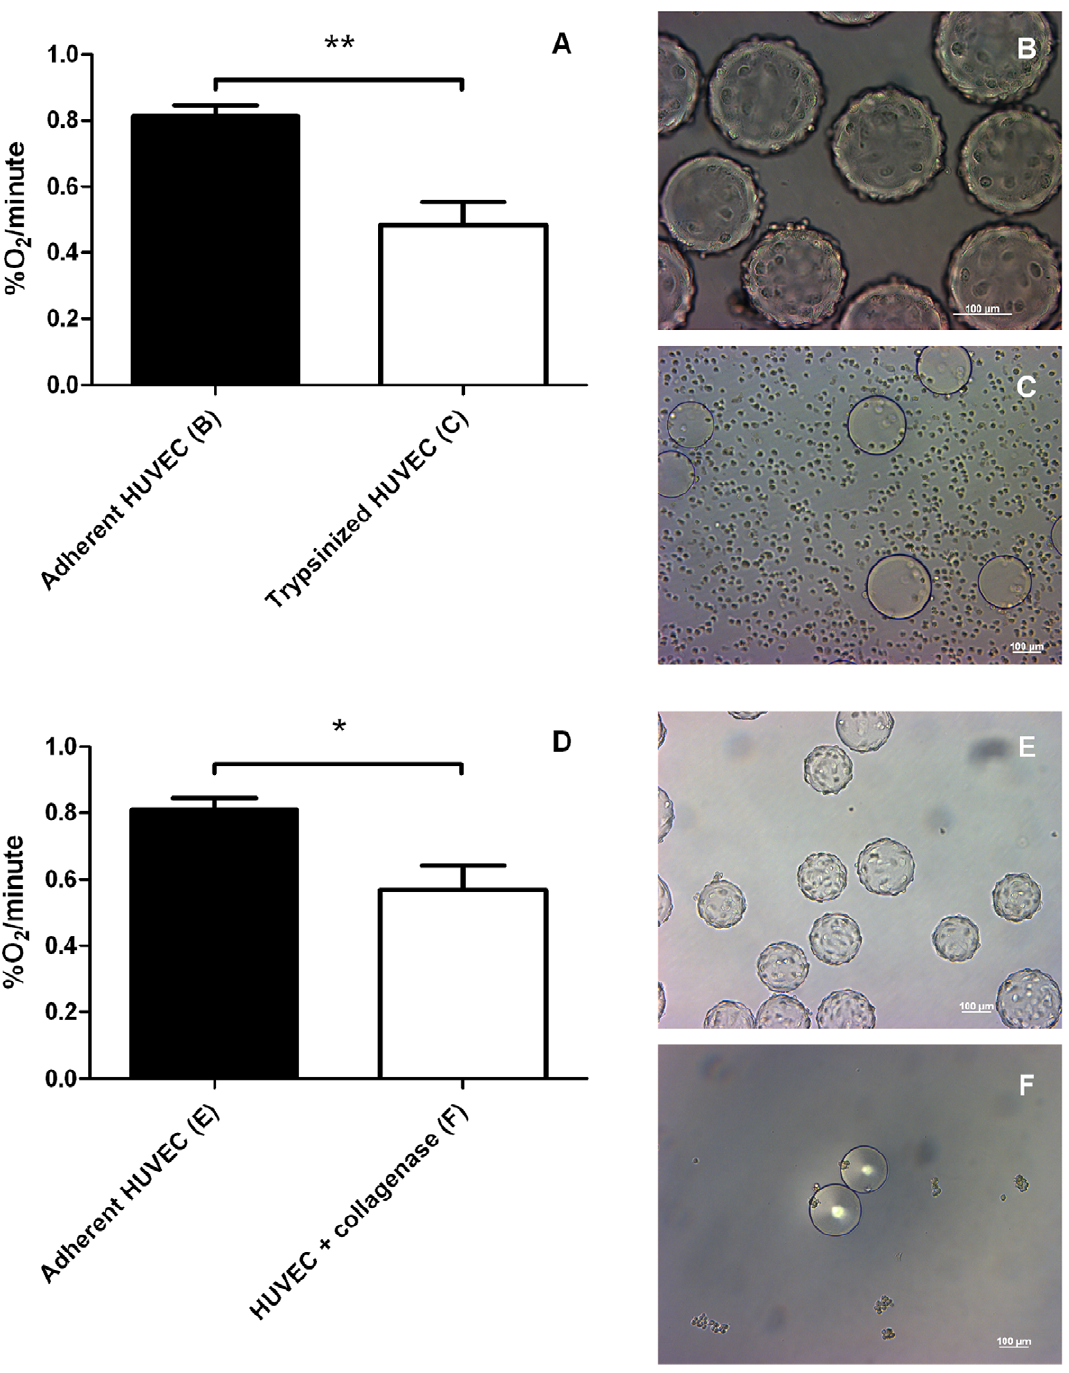
Figure 4. Effect of detachment procedures on HUVEC cells. OCR values (%O 2 /minute) (A, D) of adherent and detached HUVECs. Trypsinized (n=3) or collagenase group (n=3) show also a decreased oxygen consumption rate compared to adherent group (n=3 for A and D). Results are statistically significant (** p , 0.01 for trypsinized cells, * p , 0.05 for HUVEC + collagenase). Microscopy pictures confirm cell detachment using trypsin (C) and collagenase (F) while control cells remain adherent (B, E). Data are expressed as means 6 SEM. doi:10.1371/journal.pone.0053324.g004 reduces the OCR of tumor and endothelial cells. HUVECs were detachment procedures and not experimental bias, mitochondrial COXI protein expression was assessed using Western Blotting grown on Cytodex 3 and both harvesting methods were carried out from the same batch of cells, meaning that the same control (Figure 5). COXI expression was not significantly altered when was used for both treatments. Furthermore, to ensure that the cells were detached with trypsin or collagenase (100 6 7.02% observed decreases in the OCR reflect cellular stresses induced by